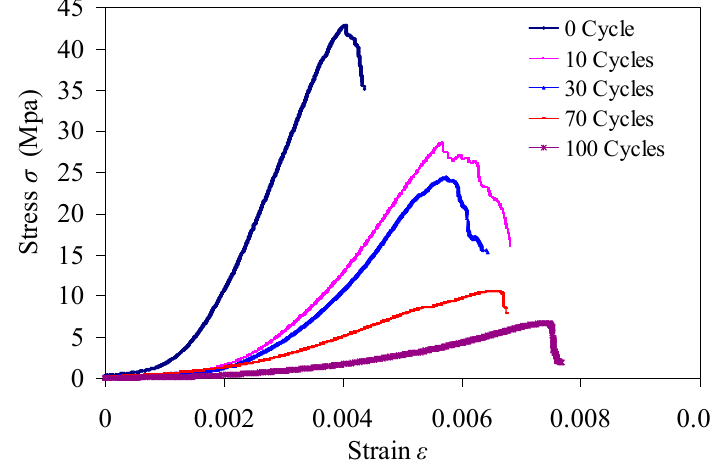
Figure 9. Typical stress–strain curves of samples.